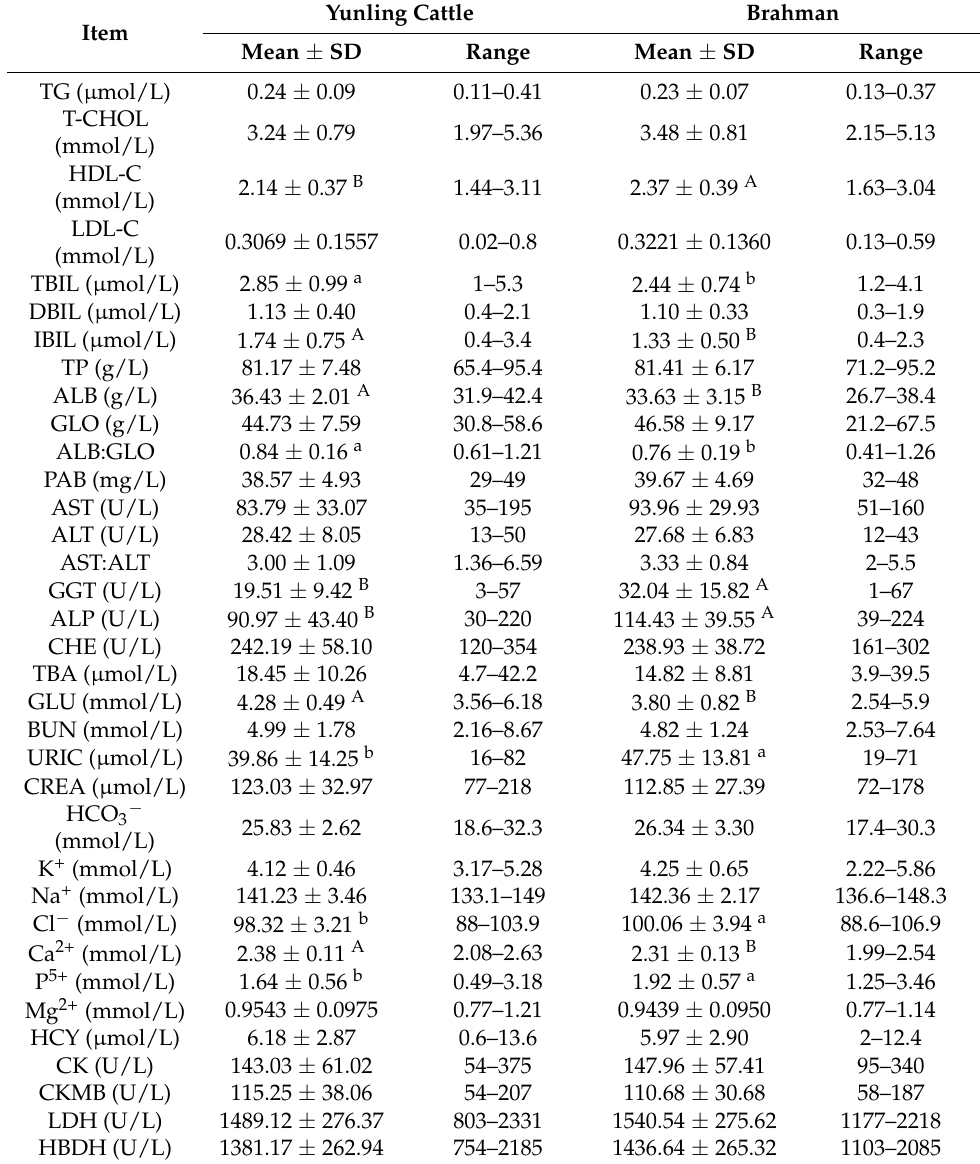
Table 3. Comparisons of blood biochemical indicators between Brahman and Yunling cattle.